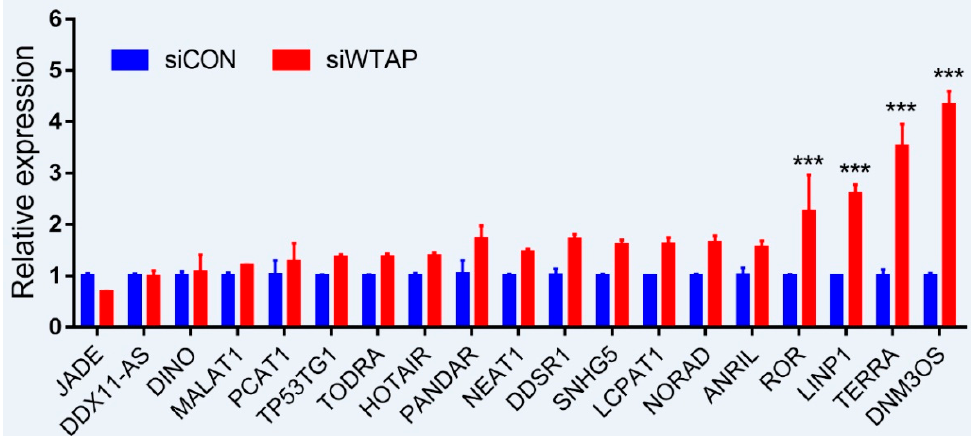
Figure 2. Expression analysis of lncRNAs through RT-qPCR from the siControl- and siWTAP-transfected HCC cell lines (SMCC7721). The error bar represents the standard deviation of each mean value (mean ± SD; n = 3). Asterisks indicate significant differences compared with the controls. *** represents significant difference compared with control group.